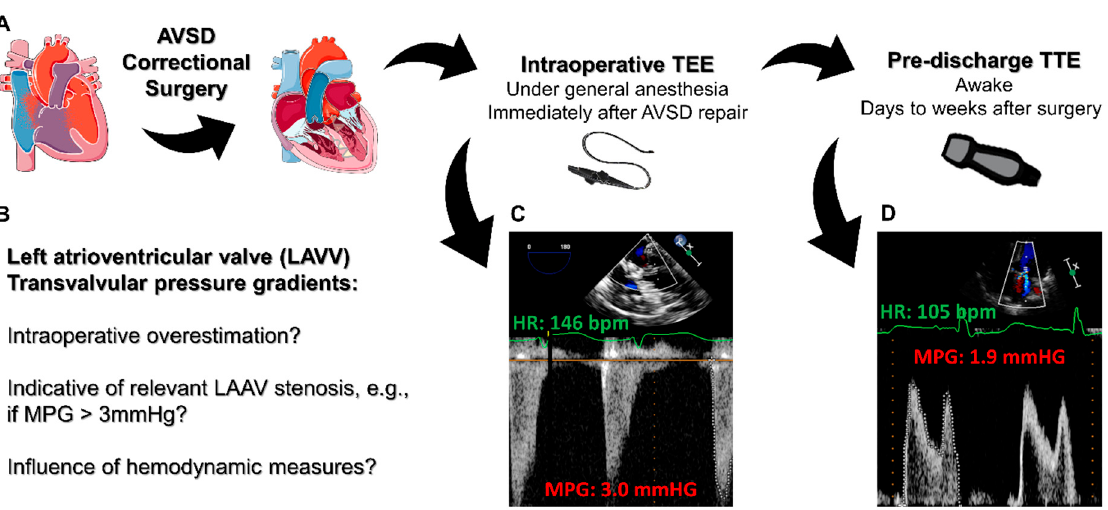
Figure 1. Graphical overview of the study’s design, underlying questions and exemplary findings. The patient cohort consisted of retrospectively selected pediatric patients undergoing surgical repair of a congenital atrioventricular septal defect (AVSD) whose transvalvular pressure gradients of the left atrioventricular valve (LAVV) were quantified with an intraoperative transesophageal echocardiography (TEE) immediately after an AVSD repair and an awake transthoracic echocardiography (TTE) prior to hospital discharge ( A ). The study was conducted to facilitate the interpretation of LAVV transvalvular pressure gradients following an AVSD at the two time-points, focusing on the detection of relevant postoperative LAVV stenosis and the role of the hemodynamic state ( B ). Representative pulsed-wave Doppler-based quantification of a patient using intraoperative TEE ( C ) and pre-discharge TTE ( D ), illustrating E/A wave fusion with higher heart rates. MPG = mean pressure